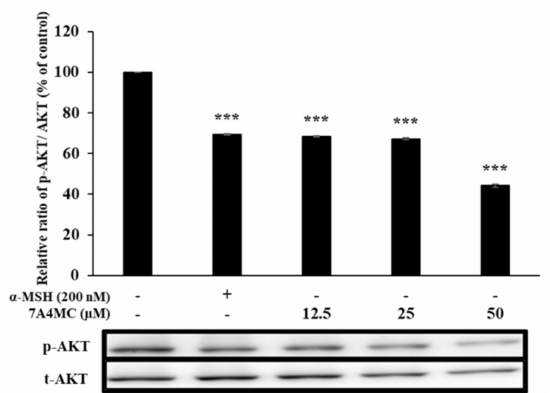
Figure 6. E ff ects of 7A4MC on the phosphorylation of p-AKT. B16F10 cells were treated with 7A4MC at the indicated concentrations for 4 h—the result of Western blot and protein level of p-AKT. The data represent the mean ± SD of triplicate experiments. *** p < 0.005. p: Phosphorylated, t: Total.